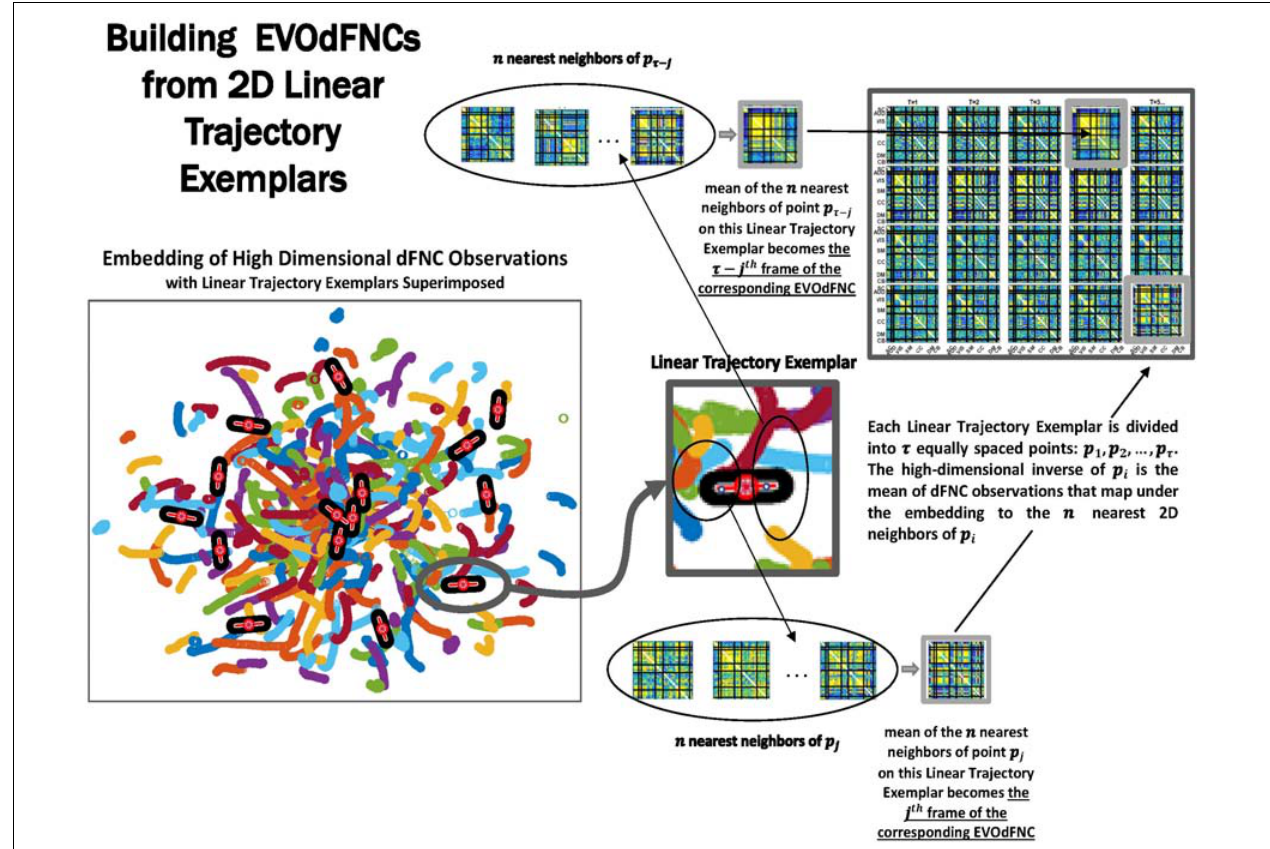
FIGURE 7 | Exemplars are divided into τ evenly spaced points: p 1 , p 2 ,... p τ (where τ is the mean temporal duration of the piecewise linear approximations of continuous trajectories that are inputs to the clustering). The geometric length of each exemplar is the based on the lengths of the continuous trajectory segments belonging to the cluster they represent. Timepoint t = i , i = 1 , 2 ,..., τ of the multifrane EVOdFNC corresponding to linear exemplar k is the average of the observed high-dimensional dFNCs corresponding to the n = 25 nearest 2D neighbors of p i